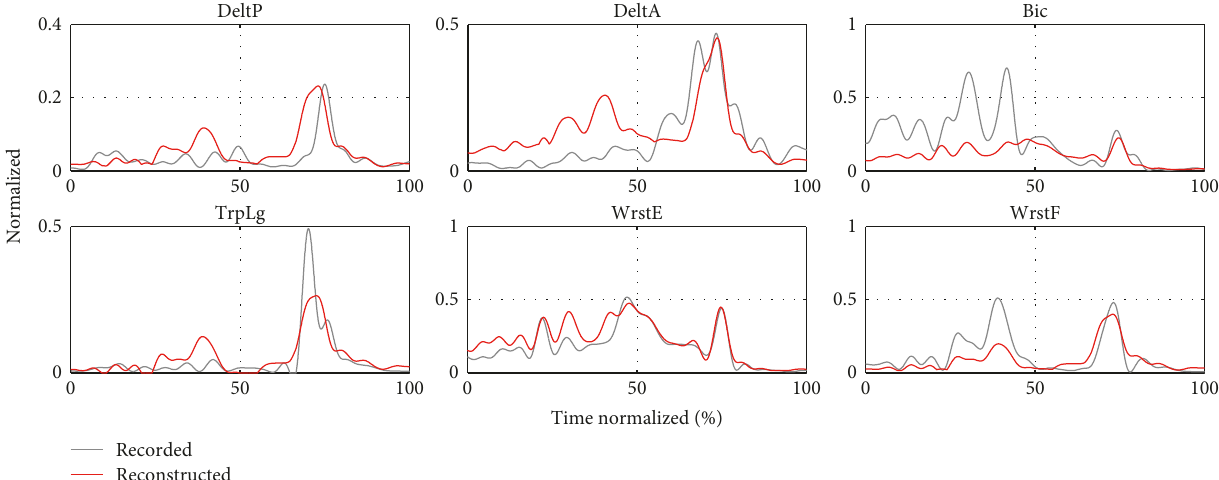
C II,All and II,All t